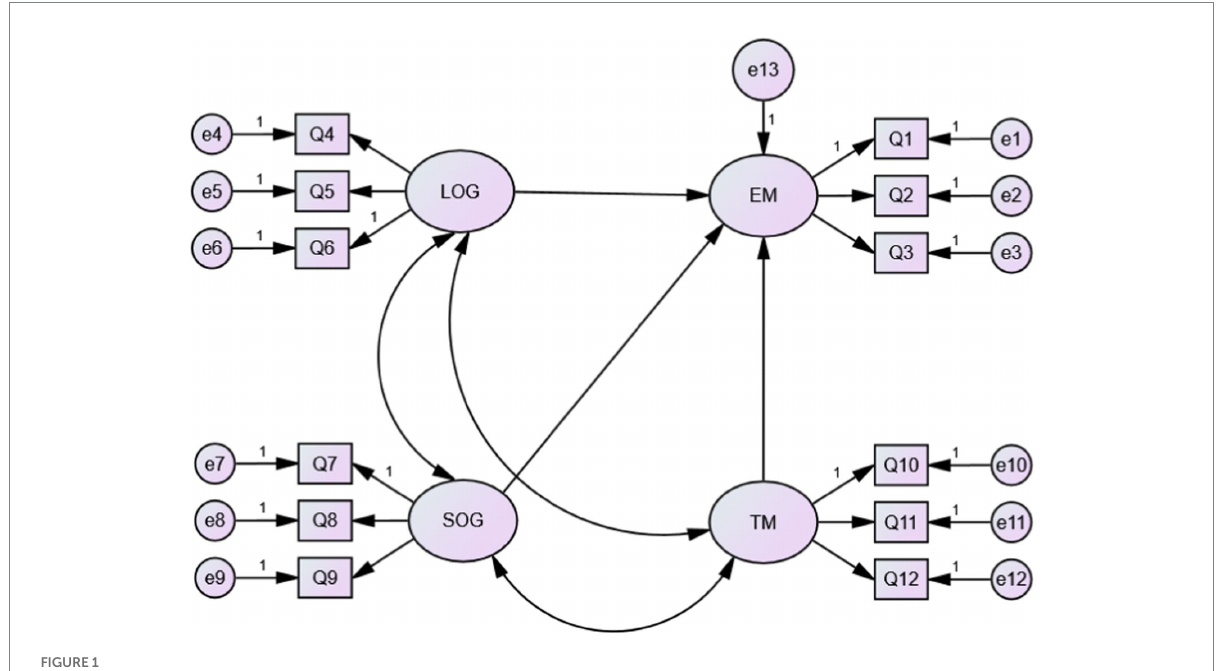
FIGURE 1 The research